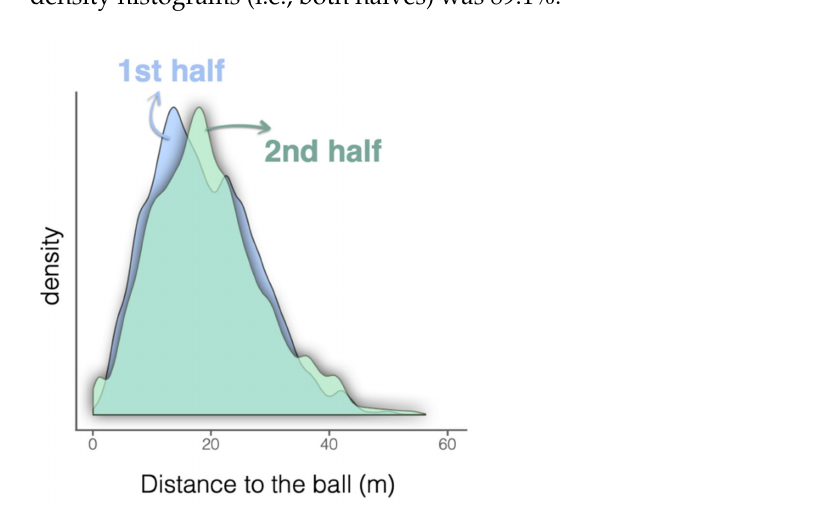
Figure 3. Density distribution of the distance from the referee to the ball for each